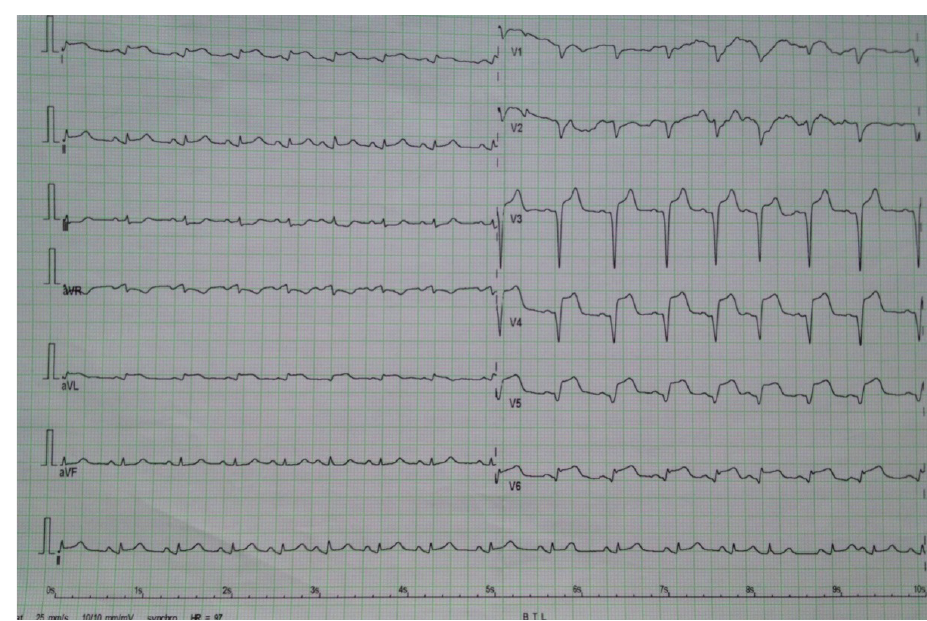
Fig. 1. 12-lead electrocardiogram in the patient with extensive anterior STEMI (11 h after onset of symptoms).